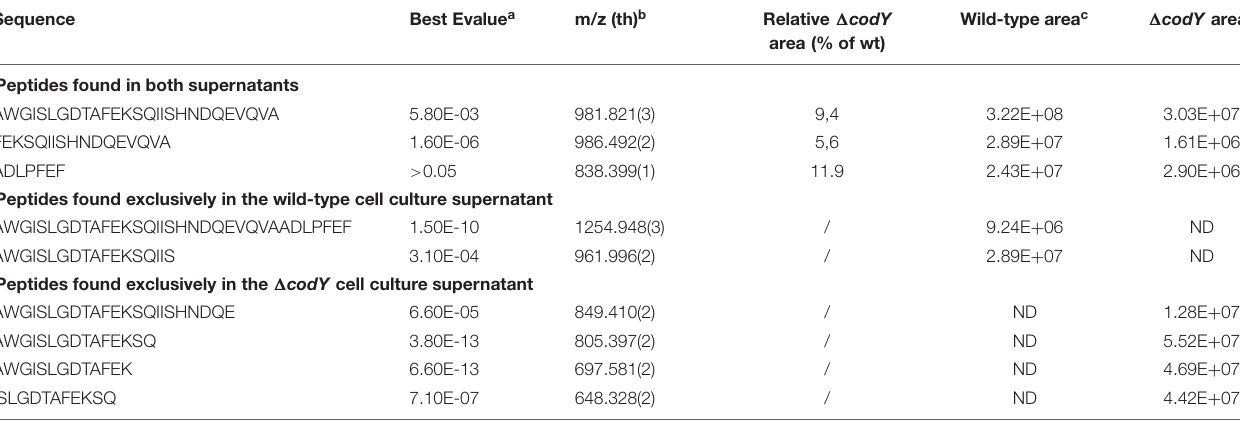
Wild-type area c (cid:2) codY area c area (% of wt)